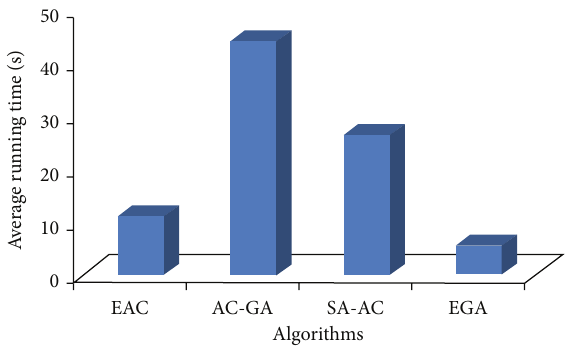
Figure 15: Comparison of average running time on map I.